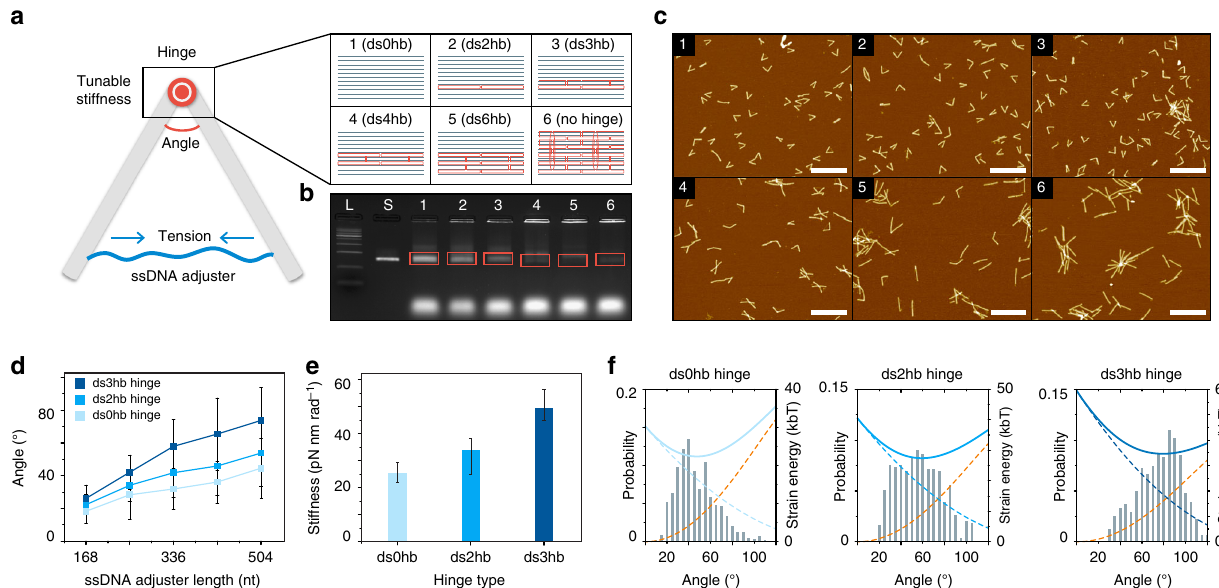
Fig. 5 Analysis of the hinge stiffness. a Schematic illustration of the test design. Here, a ssDNA adjuster strand was used to make it as a tensional component. The stiffness of the hinge can be controlled by changing the number of dsDNA and staple crossovers at the hinge section. b Agarose gel electrophoresis result. Orange boxes are monomer structure bands, and the bottom bands are excessive staples. L: 1 kb DNA ladder. S: M13mp18 scaffold. 1 – 6: folded structures with each hinge stiffness. c AFM images of each hinge design. See Supplementary Fig. 27 for large-area images. Scale bars: 500 nm. d Measured average included angles of three different hinge designs. Error bars indicate standard deviation. See Supplementary Figs. 28 – 31 for more details. e Calculated bending stiffness of each hinge design. Error bars indicate maximum and minimum stiffness values. f Strain energy analysis of the structures with different hinge designs with a 504-nt-long ssDNA adjuster. Gray bars represent experimental included angle distribution, blue-dashed lines are the strain energy stored in the hinge, orange-dashed lines are the entropic energy of ssDNA adjuster, and the blue-solid lines indicate the summation of the two energies, respectively. See Supplementary Fig. 37 for a complete